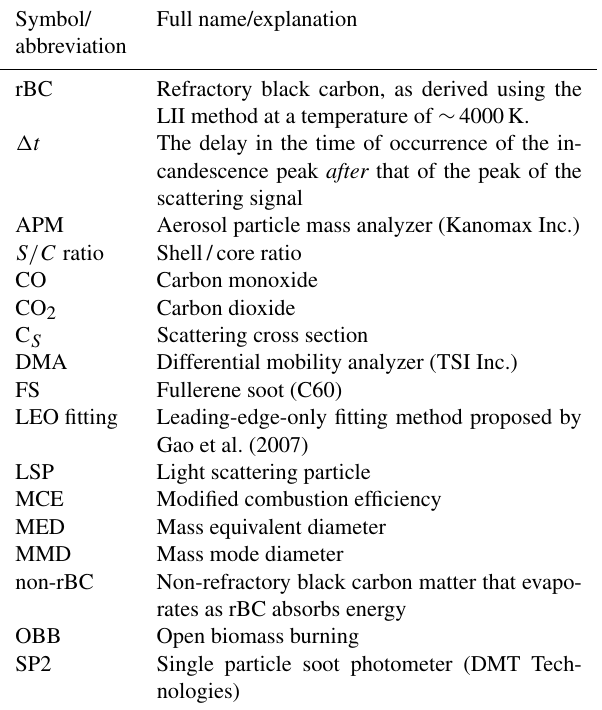
Table 1. Abbreviations and symbols used in this